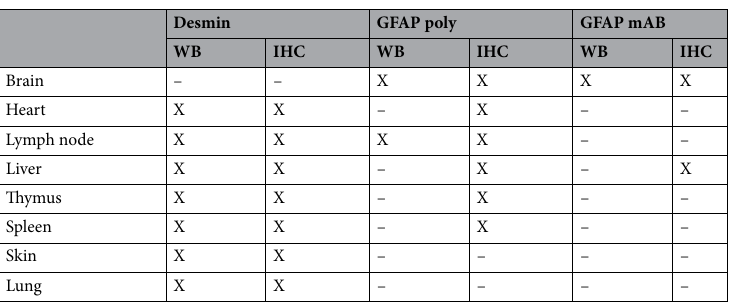
Table 1. Summary of WB analysis and the immunohistochemistry. Used antibodies for both applications against GFAP (polyclonal and monoclonal) and desmin. Except the brain desmin were positive in Western Blot and the IHC staining’s. Polyclonal GFAP showed signals in Western Blot in brain and lymph node and positive results in all organs excepted skin and lung using IHC. The monoclonal GFAP (GFAP mAB) antibody give signals in WB and IHC for brain tissue. IHC signals was observed in the